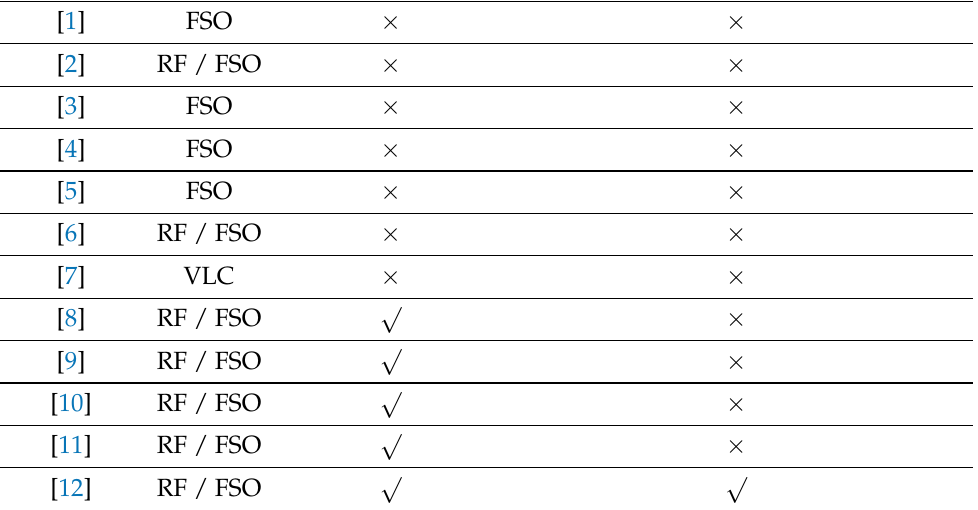
Table 1. A comparison of different